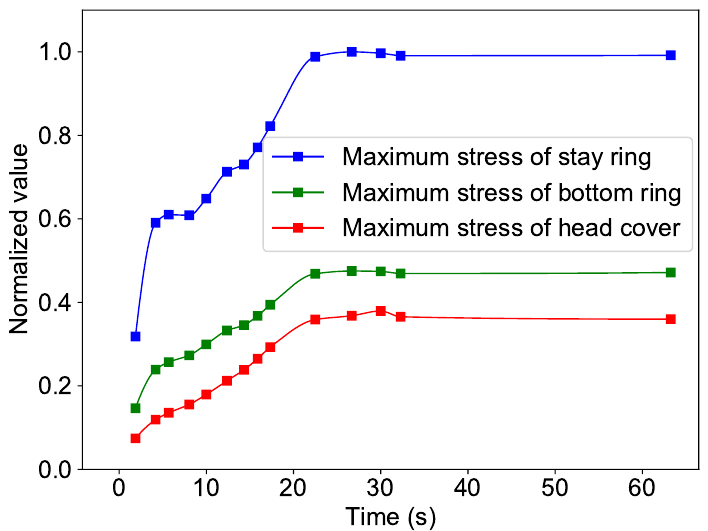
Figure 19. Comparison of maximum stresses in non-rotating structures during turbine start-up.